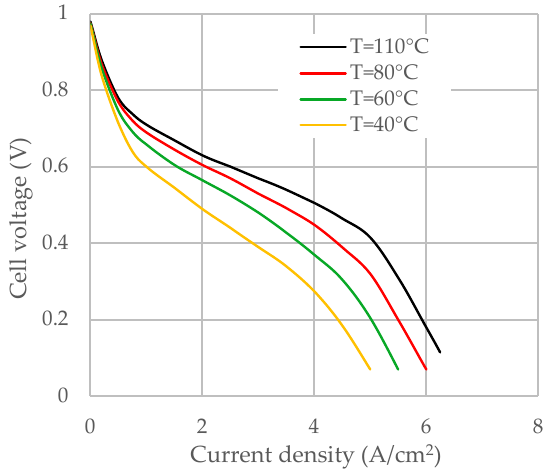
Figure 10. The effect of operating temperature on cell performance. The cell voltage for the current density of 4 Acm −2 is calculated as 0.274, 0.37, 0.448, and 0.505 V for ionic conductivity at 130, 175, 225, and 290 mScm −1 , respectively. These ionic conductivities are measured for cell temperatures at 40, 60, 80, and 110 °C, respectively. The voltage rises 35% when the working temperature is raised from 40 °C to 60 °C, but only 13% when the temperature is raised from 80 °C to 110 °C. A similar effect can be seen in the activation polarization region where the cell voltage for the current density of 0.5 Acm −2 is calculated as 0.715, 0.747, 0.77, and 0.782 V for the cell temperatures of 40, 60, 80, and 110 °C, respectively. This demonstrates that the influence of temperature on cell performance is more significant at lower temperatures than it is at higher temperatures.